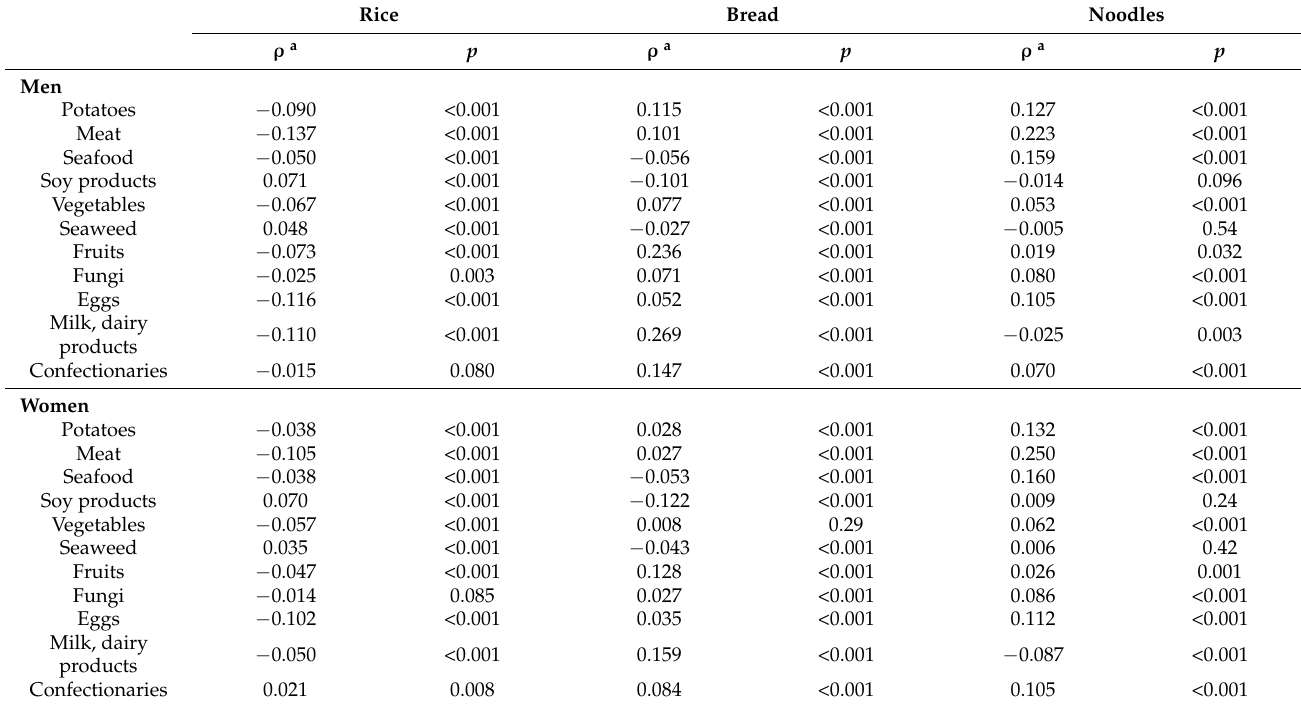
Table 2. Spearman correlation coefficients between intakes of rice, breads, and noodles as grain dishes with intakes of other foods.